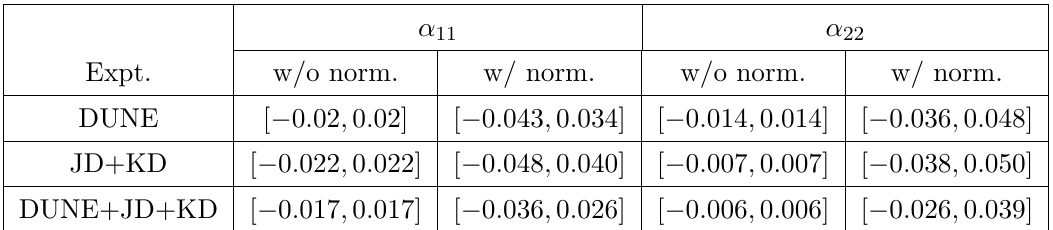
Table 8 . 90% C.L. (1 d.o.f.) limits on the NUNM parameters α 11 and α 22 for the two setups, DUNE, JD+KD, and combination of them. Second and fourth column correspond to the constraints assuming only far detector. Third and fifth columns correspond to the constraints using the FD and ND correlation (or with normalization factor in the oscillation